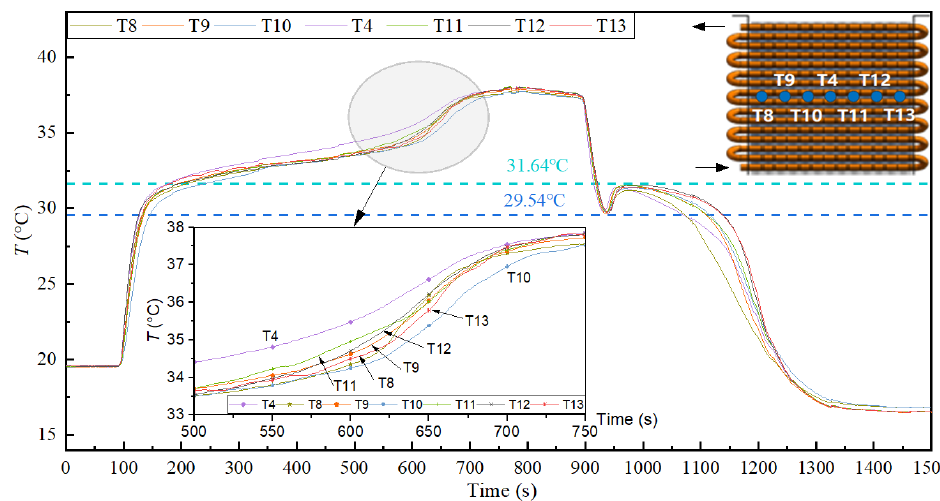
Figure 14. Transverse temperature distribution of PCM (10 wt.% EG).